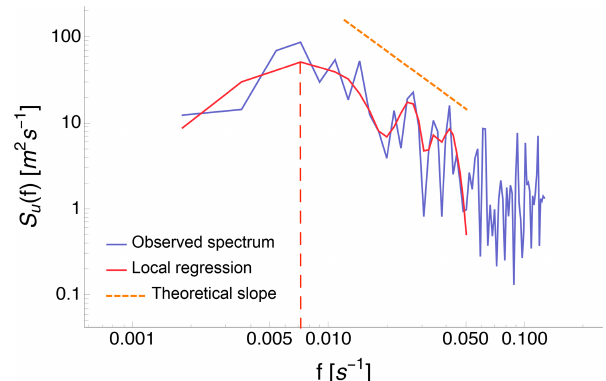
Figure 2. Example of the local regression of an experimental spec- trum of the line-of-sight velocity measured by one of the four beams of the WINDCUBE v1 lidar at Wasco Airport at WFIP2. The red dashed line shows the maximum of the local regression curve. The orange dashed line shows the theoretical − 5 / 3 slope of the spec- trum in the inertial